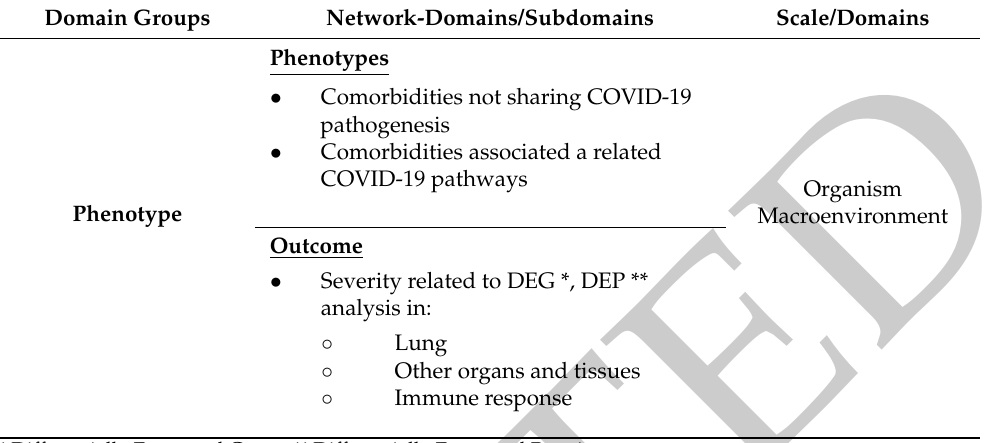
Table 1. Cont. Domain